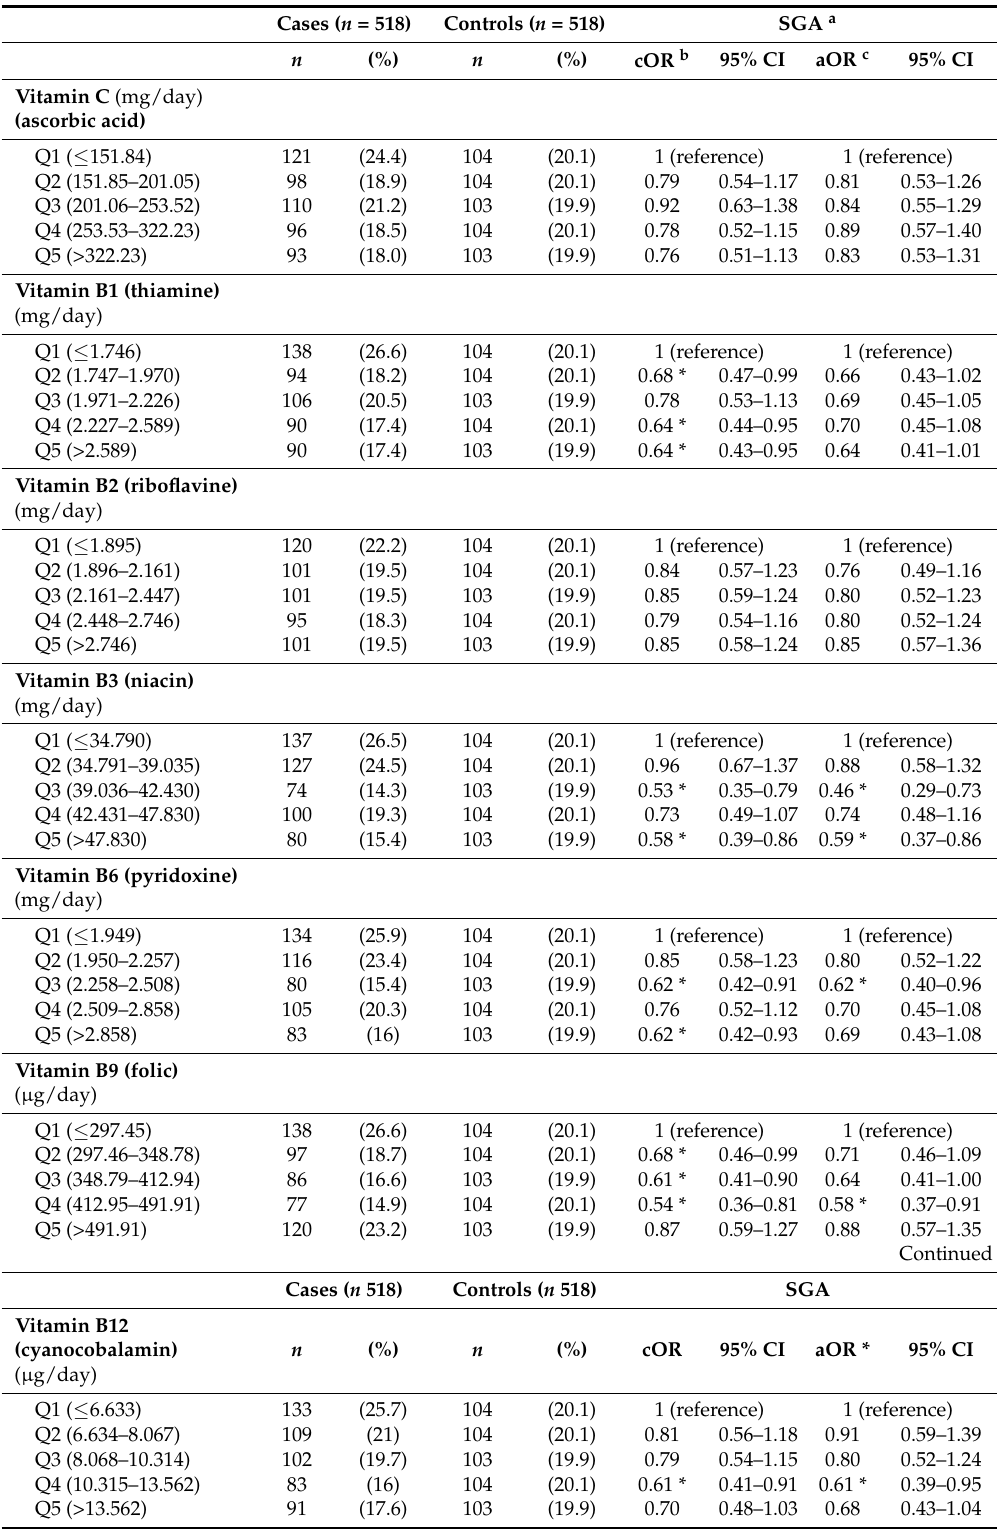
Table 3. Level of intake of hydrosoluble vitamins during pregnancy among healthy Spanish women ( n =